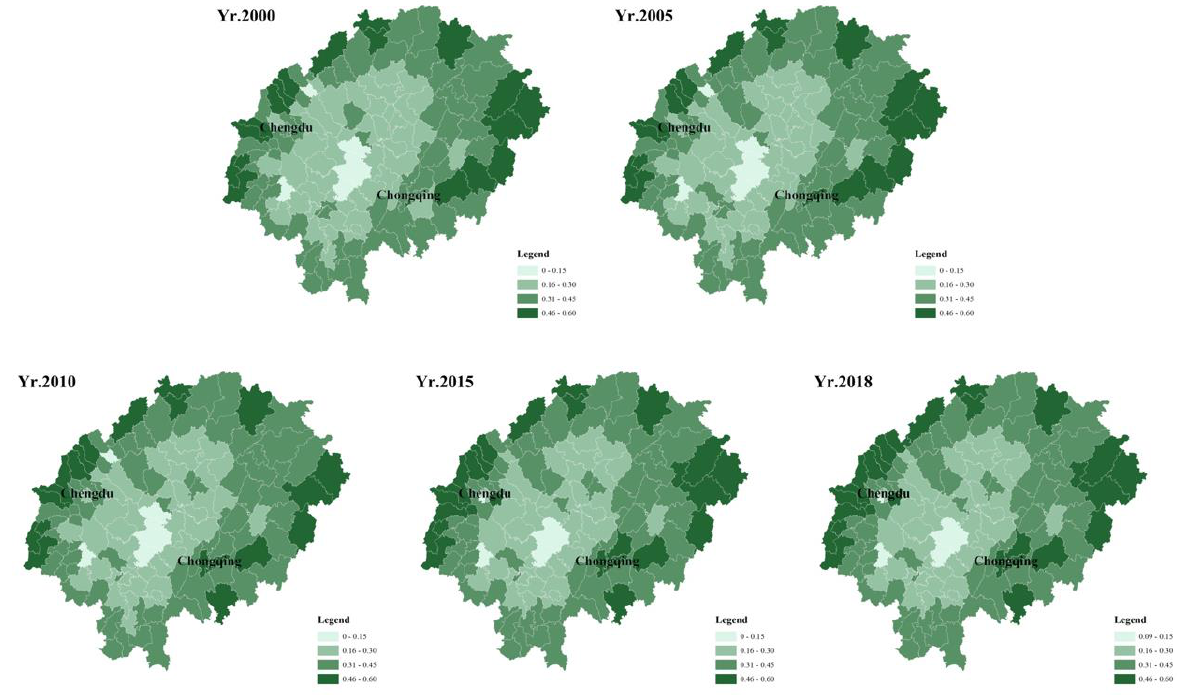
Figure 5. Information entropy of land use structure distribution map: 2000 – 2018.